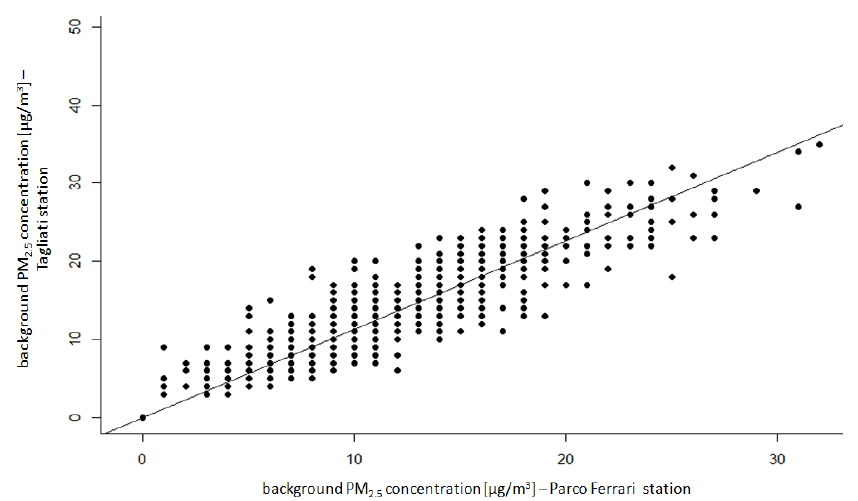
Figure 1. Linear regression line: background PM 2.5 concentration ( µ g / m 3 ) measured at Tagliati station vs. background PM 2.5 concentration ( µ g / m 3 ) measured at the Parco Ferrari station.